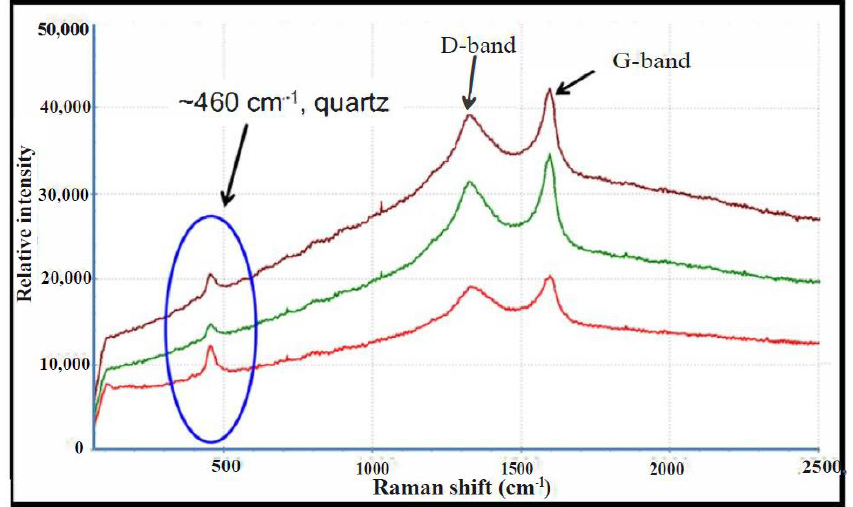
Figure 9. Raman spectra for laboratory-generated dust samples consisting of 80% coal and 20% quartz. Raman spectroscopy has been used to characterize cement, marine aerosol, and re- suspended dust (with 532 nm laser) [300,311]. Stacey et al. [312] shows that the size of particles does not alter the Raman responses for the mass of 0.25–10 µ g